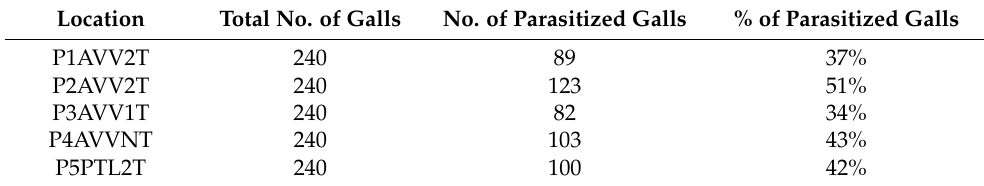
Table 4. Absolute and relative values of spring galls parasitized by T. sinensis and autochthonous parasitoids in five chestnut orchards in Minho (P1 to P5) located in Arcos de Valdevez (AVV) and Ponte de Lima (PTL), with one (1T), two (2T) or no treatment (NT) of T. sinensis (NT) in 2018. Location Total No. of Galls No. of Parasitized Galls % of Parasitized Galls P1AVV2T 240 89 37% P2AVV2T 240 123 51% P3AVV1T 240 82 34% P4AVVNT 240 103 43% P5PTL2T 240 100 42% The parasitism rate (Table 5) varied between 6.7% (P3AVV1T) and 9.7% (P2AVV27),